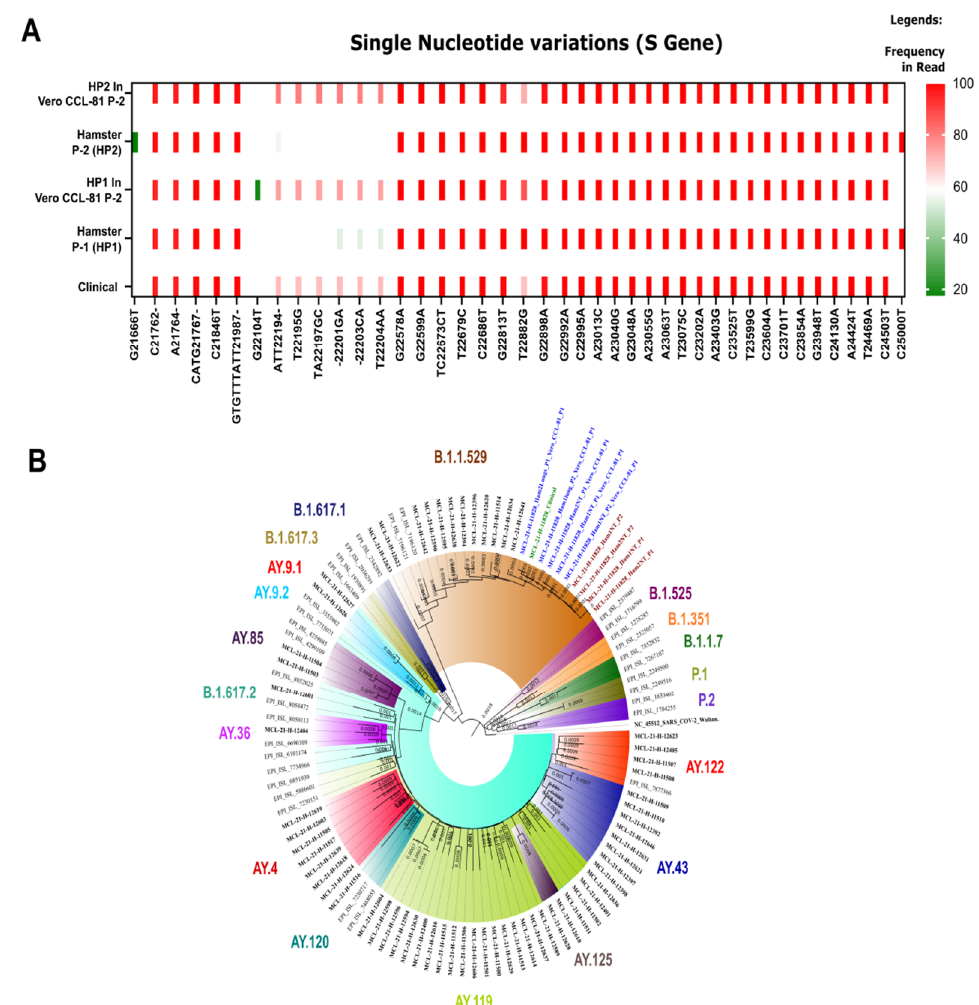
Figure 2. Single nucleotide variations (SNV) and phylogenetic tree of the Omicron clinical and its isolate sequences: ( A ) Single nucleotide variation in the S gene and its frequency in different in vivo and in vitro sequences. The x axis is the SNVs and y axis marks the frequency. ( B ) Neighbour joining tree with a bootstrap replication of 1000 cycles to assess statistical robustness. The sequences retrieved from human clinical specimen, hamsters passages, and cell culture passages are marked in green, brown, and blue boldfaced font, respectively. The sequences of other SARS-CoV-2 variants retrieved in this study highlighted with black boldfaced. The representative SARS-CoV-2 sequences are marked in black regular